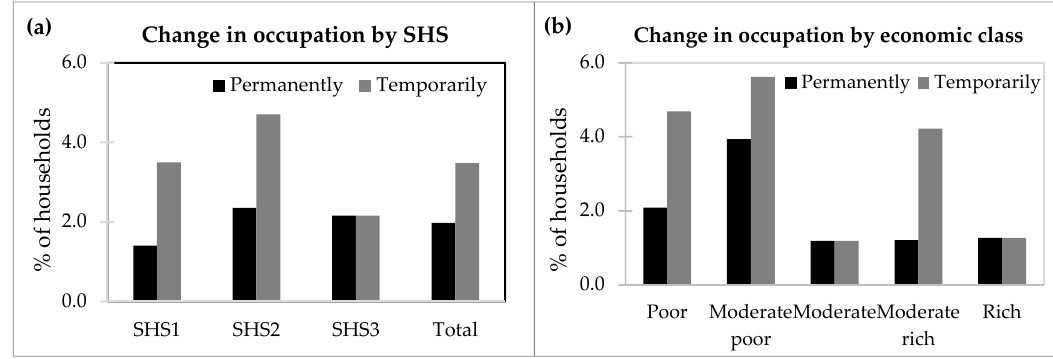
Figure 6. Change in occupation of households in the study area. ( a ) Change in occupation by SHS. ( b ) Change in occupation by economic class.